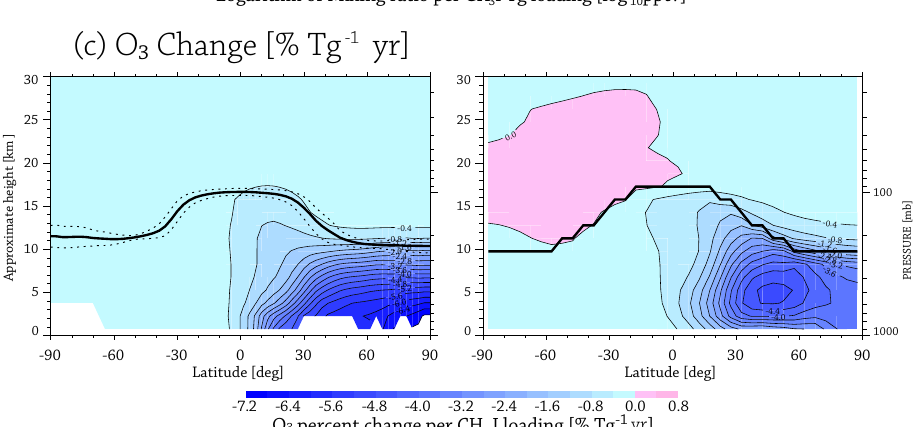
Fig. 8. Annually averaged changes in (a) CH 3 I and (b) I y , (c) ozone for CH 3 I mid-latitude emission scenario relative to background atmospheric conditions without CH 3 I